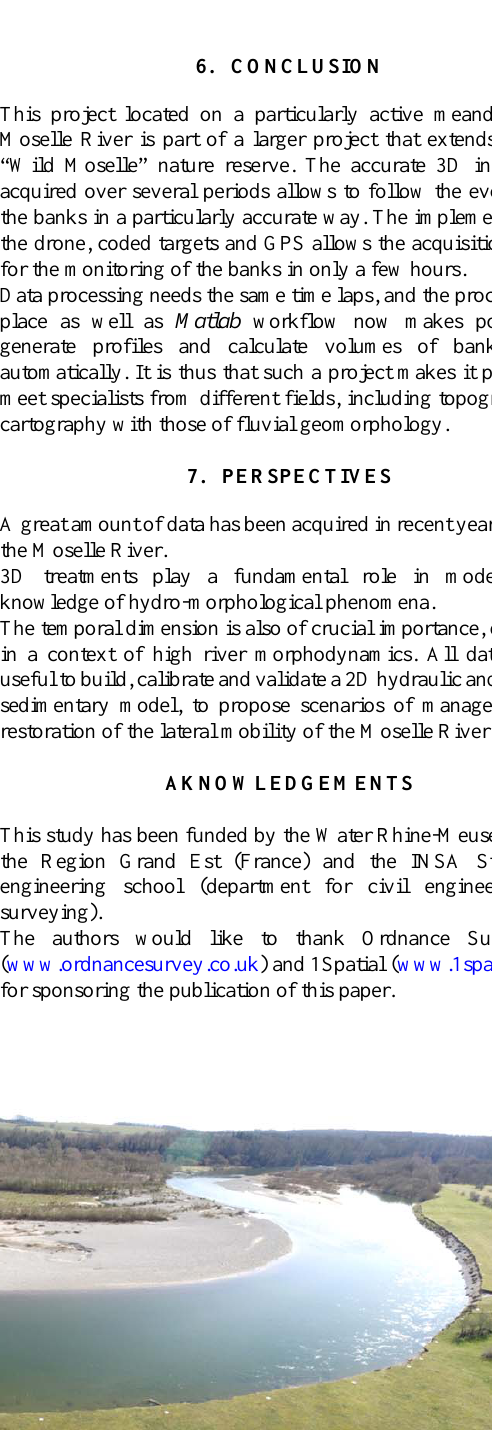
Figure 10: Stitched panoramic image of the studied meander